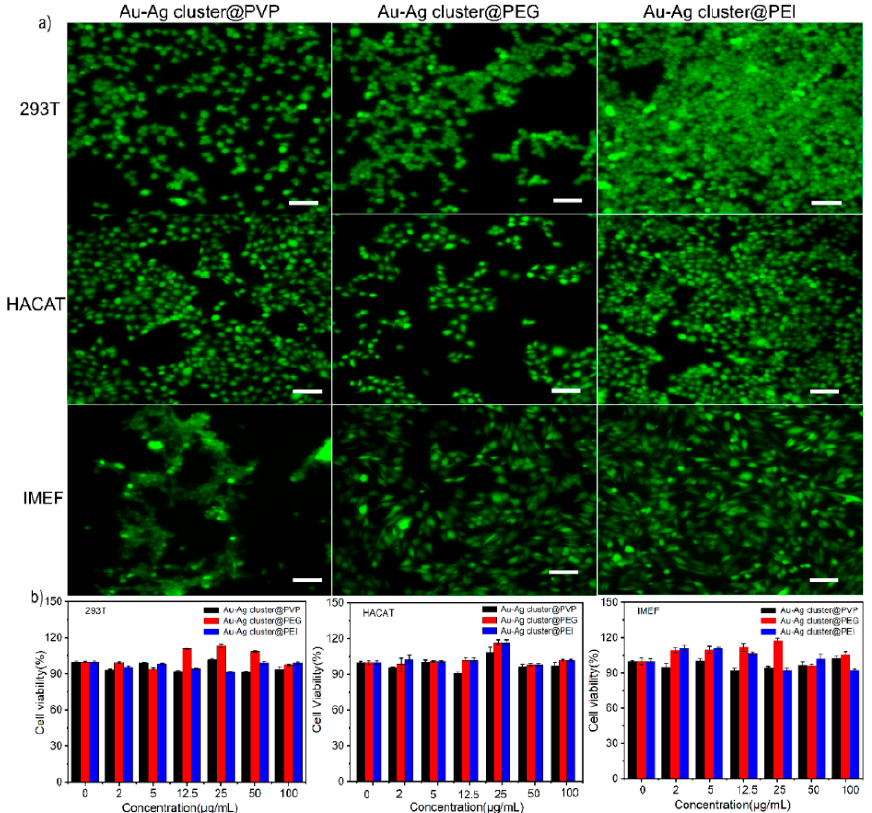
Figure 7. ( a ) Representative fluorescence microscopy images of 293T, HACAT and IMEF cells, were treated by using 50 µ g mL − 1 colloidal solutions (Au-Ag cluster @PVP, Au-Ag cluster@PEG400 which were treated by using 50 µg mL − 1 colloidal solutions (Au-Ag cluster @PVP, Au-Ag clus- and Au-Ag cluster @PEI) after 2 days, in preparation for biocompatibility measurements. The scale bar in the inset corresponds to 100 µ m; ( b ) Relative cell viability of different cell lines 293T, HACAT ments. The scale bar in the inset corresponds to 100 µm; ( b ) Relative cell viability of different cell and IMEF treated with different concentrations of modified Au-Ag cluster @PVP, Au-Ag lines 293T, HACAT and IMEF treated with different concentrations of modified Au-Ag cluster